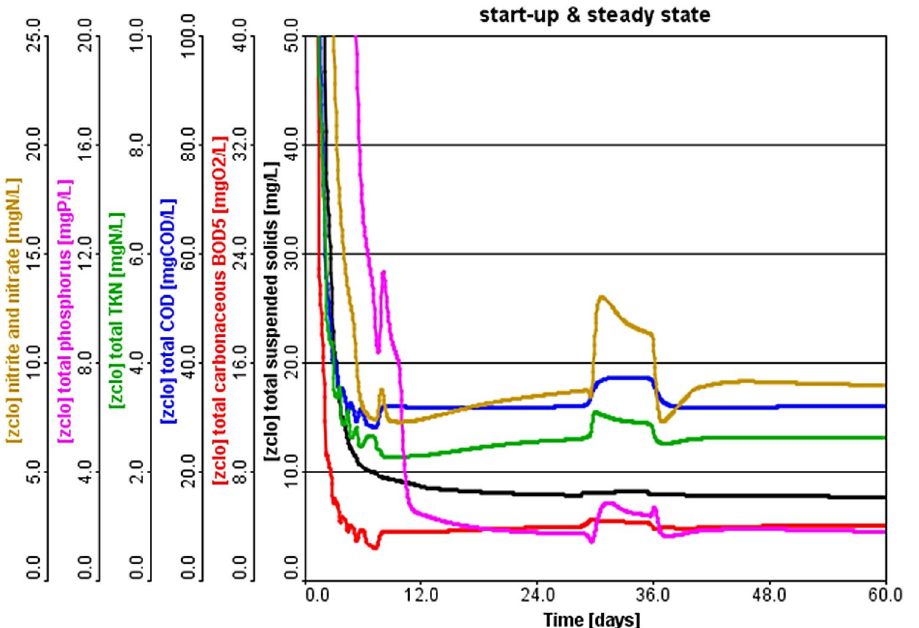
Figure 7. Performance evaluation of full scale A 2 /O system with sidestreams